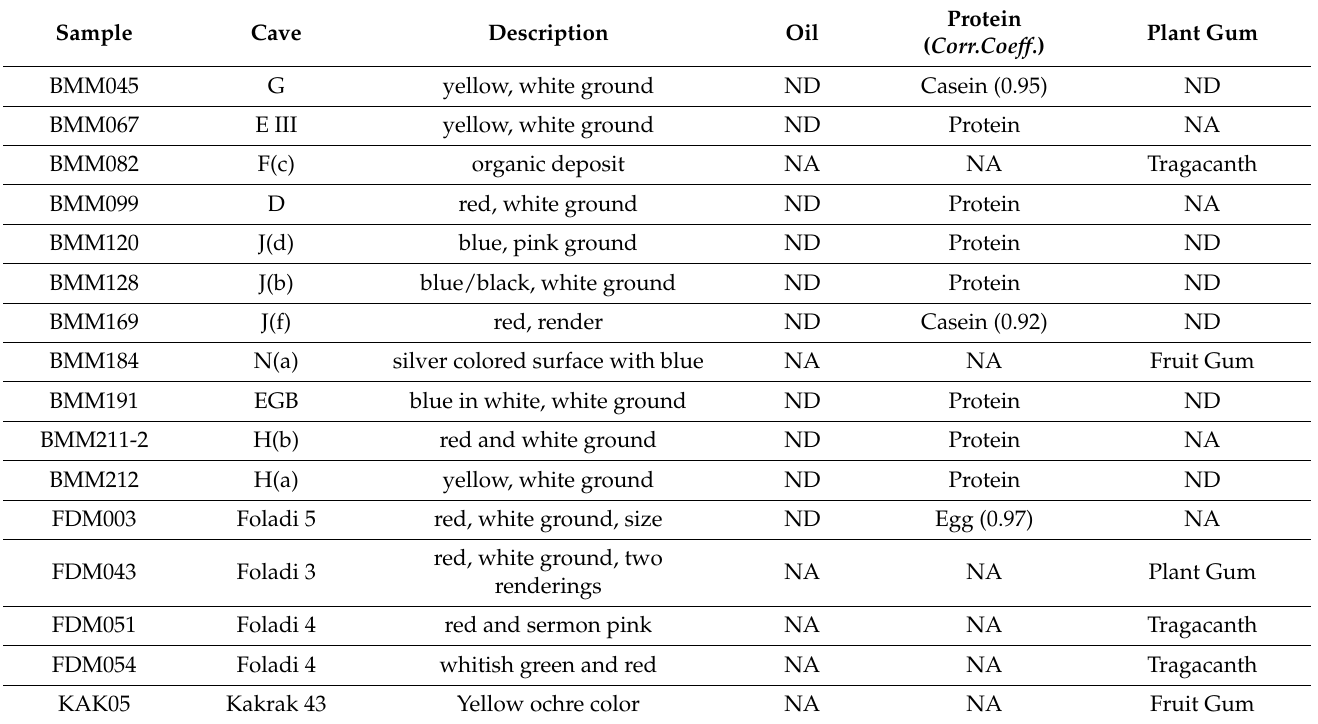
Table 5. Summary of GC-MS results for samples without oil. NA = not analyzed, ND = not detected, below detection limit. Corr.coeff. = correlation